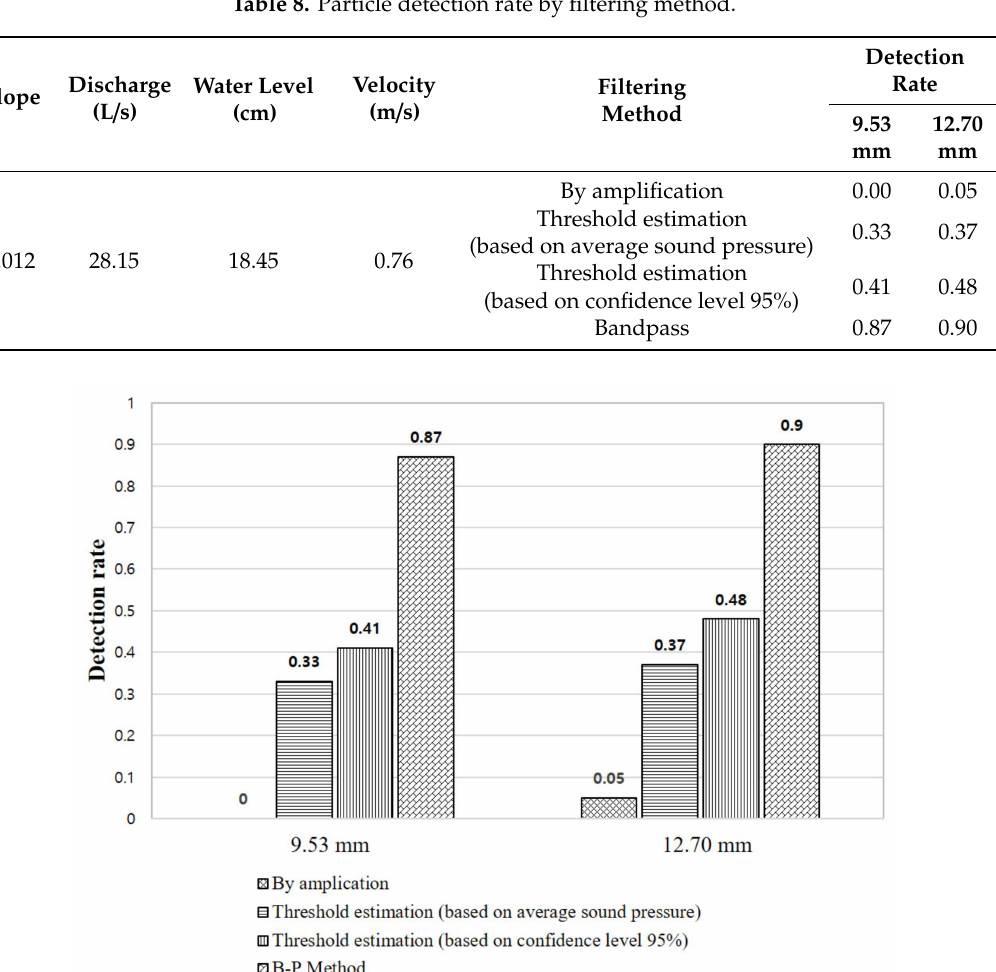
Figure 15. Particle detection rate by filtering